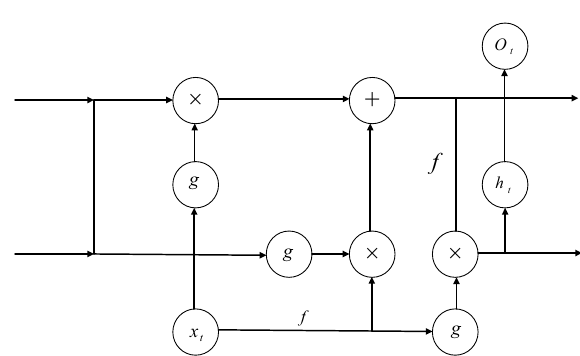
Fig. 5 Structure diagram of LSTM hidden